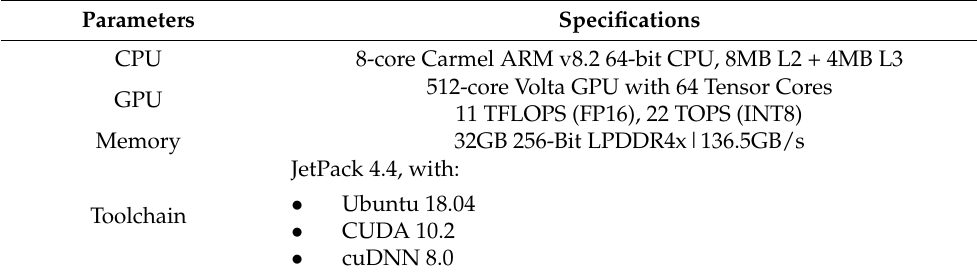
Table 10. The Specification of NVIDIA Jetson AGX Xavier.